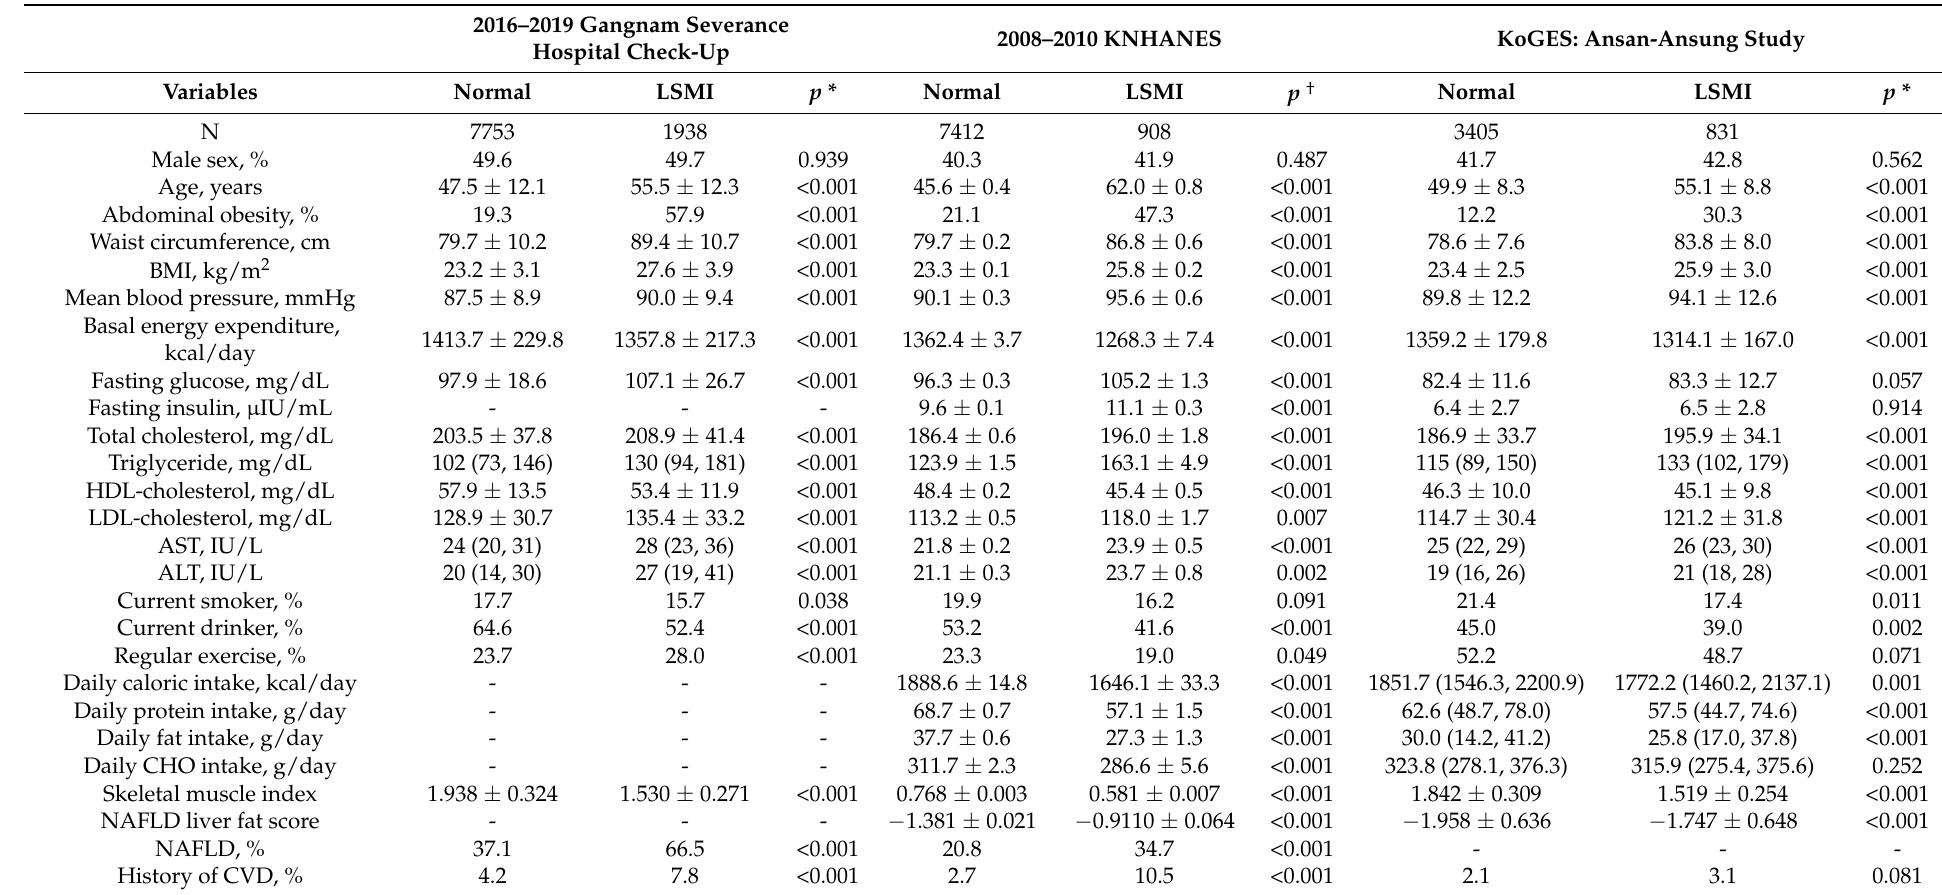
Table 2. Clinical characteristics of three different population cohorts according to skeletal muscle mass index (SMI)